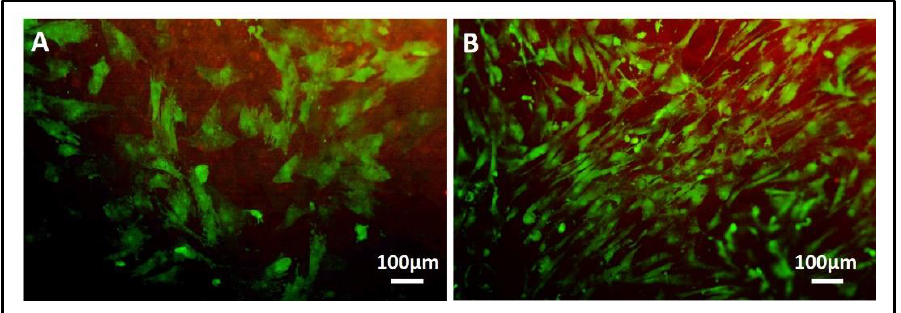
Figure 17. Representative images of osteoblasts seeded on collagen-based scaffolds containing mesoporous bioactive glasses (Coll_MBG) ( A ) and nano-hydroxyapatite (Coll_HA) ( B ) after live-dead staining at 7 days.